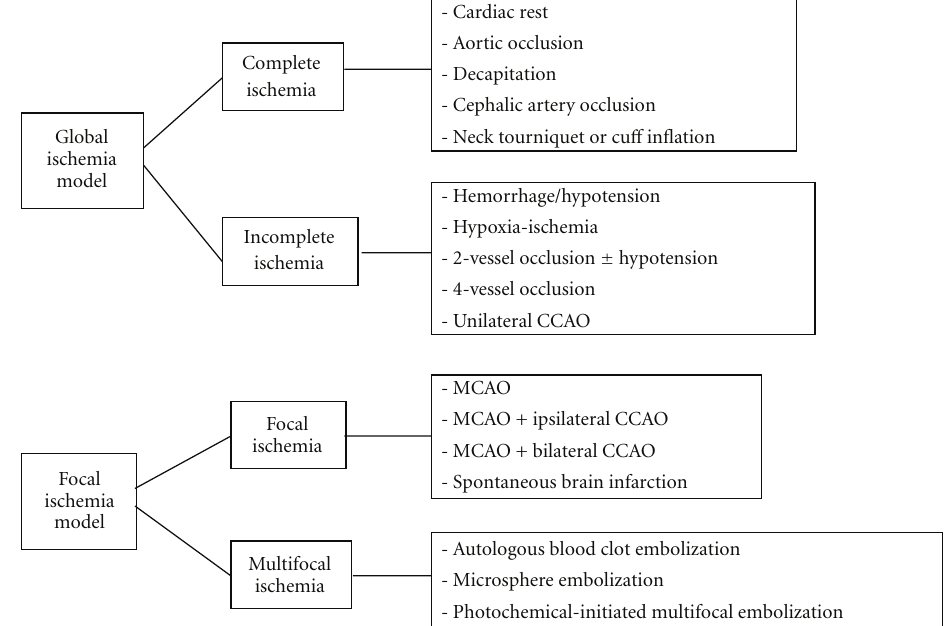
Figure 1: Major types of animal models of ischemic